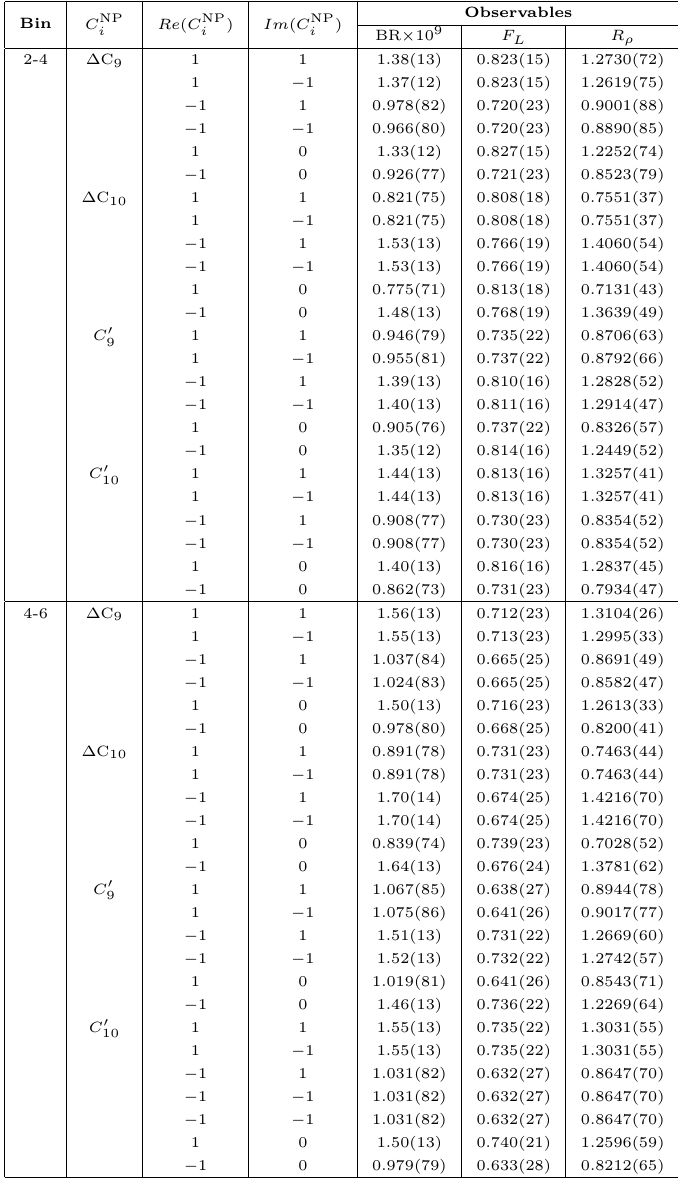
for the q 2 bins 2 − 4 9 , 10